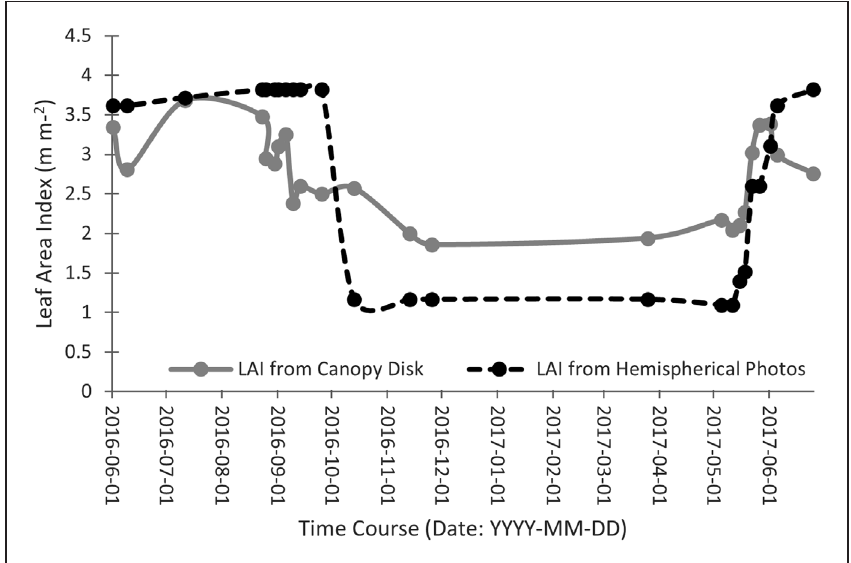
Figure 7 Leaf Area Index (LAI) in the Betula sp. stand at Lammi Biological Station over the one-year period, calculated from data collected through the canopy disk activity compared with LAI calculated from hemispherical